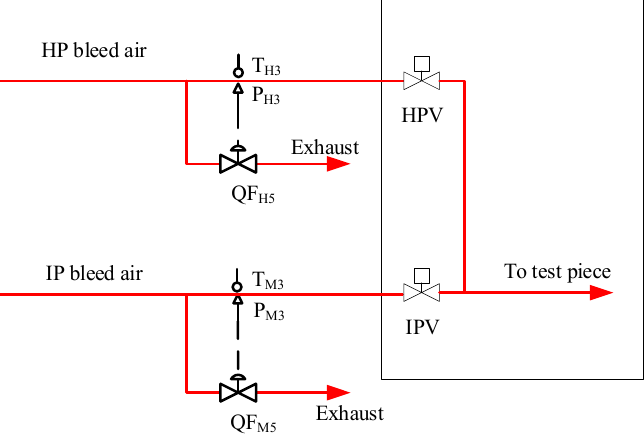
Figure 8. Rapid bleed air switching response diagram.